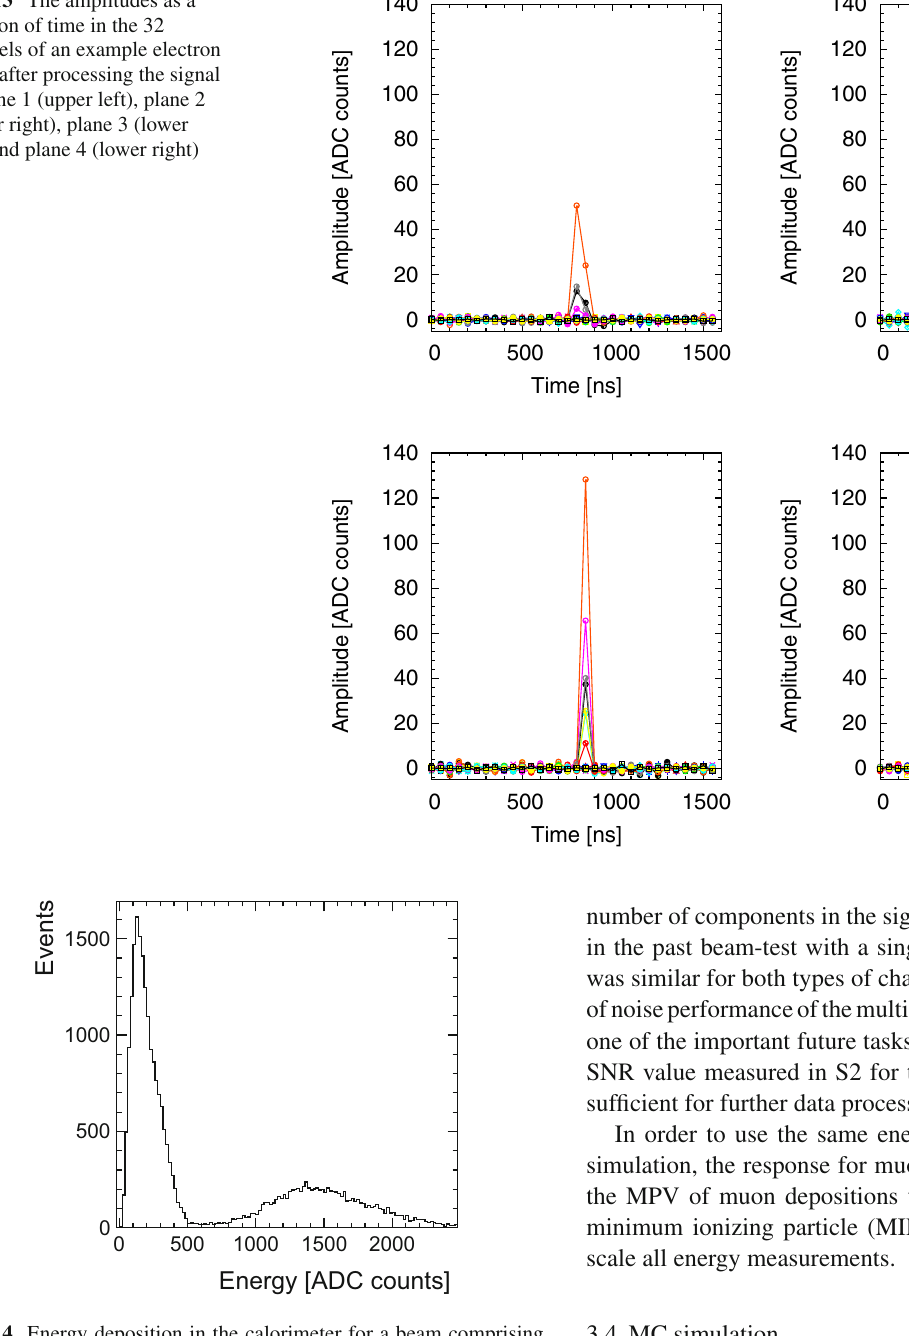
The SNR is shown in Fig. 16 for the channels of the four different sensor